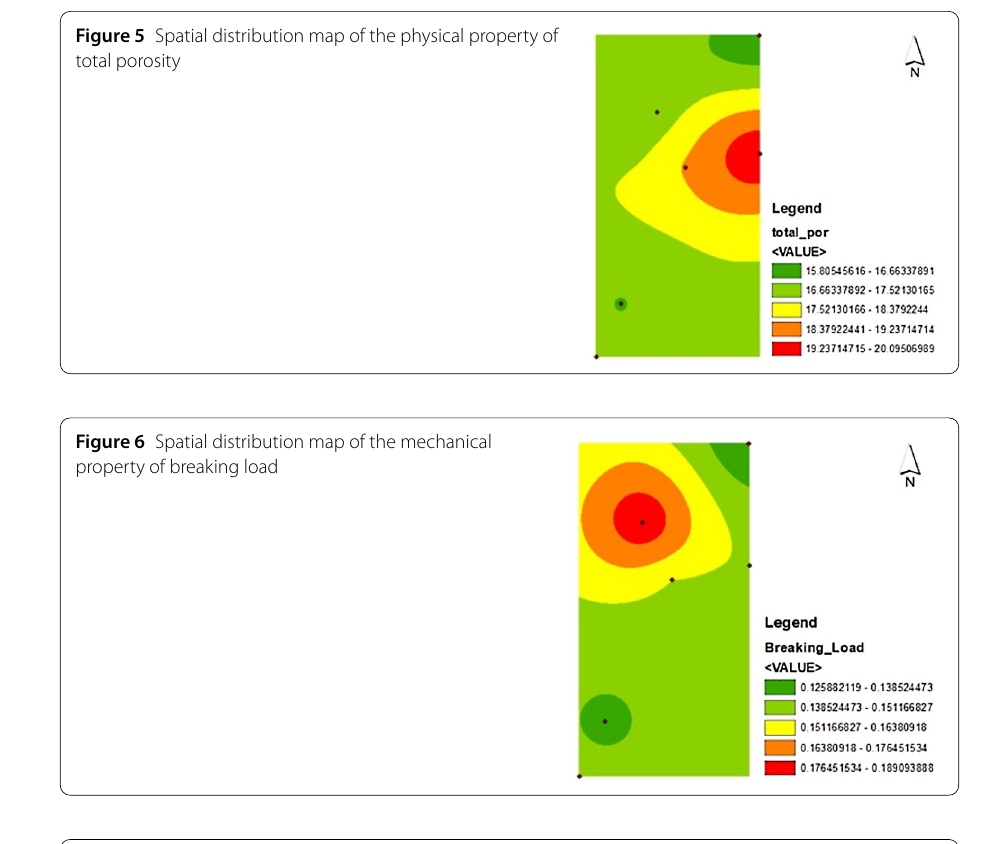
Figure 7 Spatial distribution map of the mechanical property of compressive strength